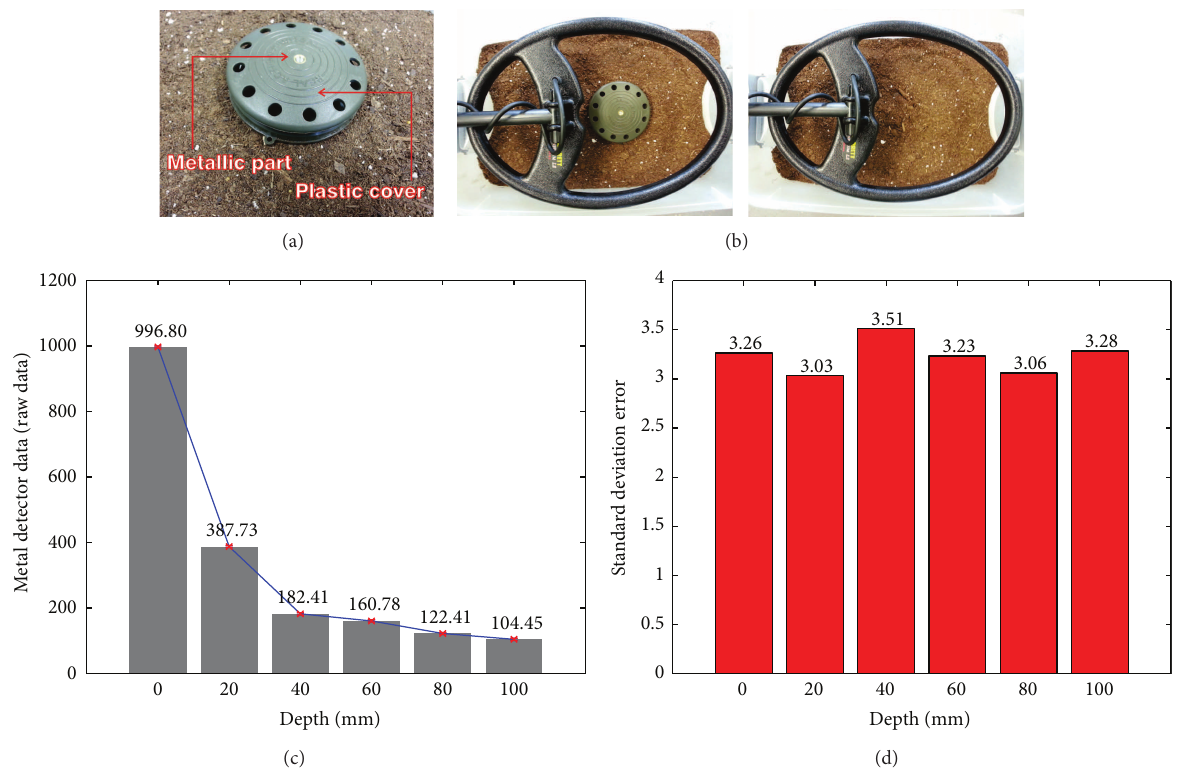
Figure 4: (a) A real action paintball mine is used to simulate mines made with few metallic parts. (b) Landmine has been buried 100mm in soil with the purpose of mine detection analysis. (c) Metal detector raw data for different buried depths of the paintball mine. (d) Standard deviation error for different depths at which the paintball mine is